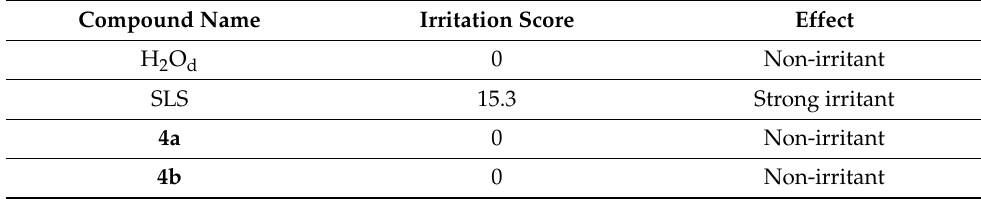
Table 3. The irritation potential of tested